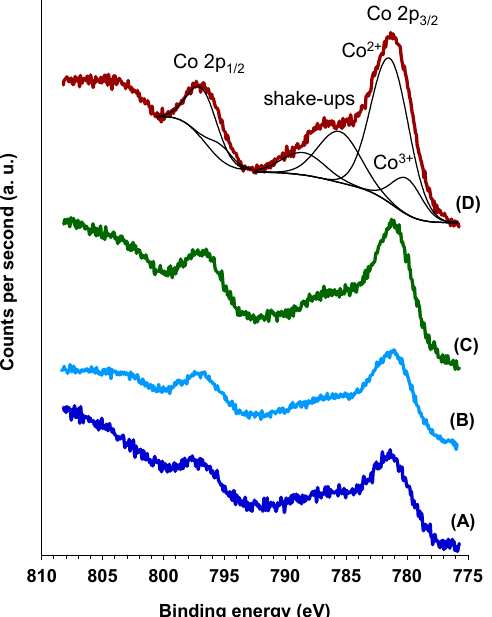
Figure 7. The X-ray photoelectron profiles of Co 2p for the Co(x)CuCeMgAlO mixed oxides: (A) x = 1, (B) x = 3, (C) x = 6, and (D) x = 9.